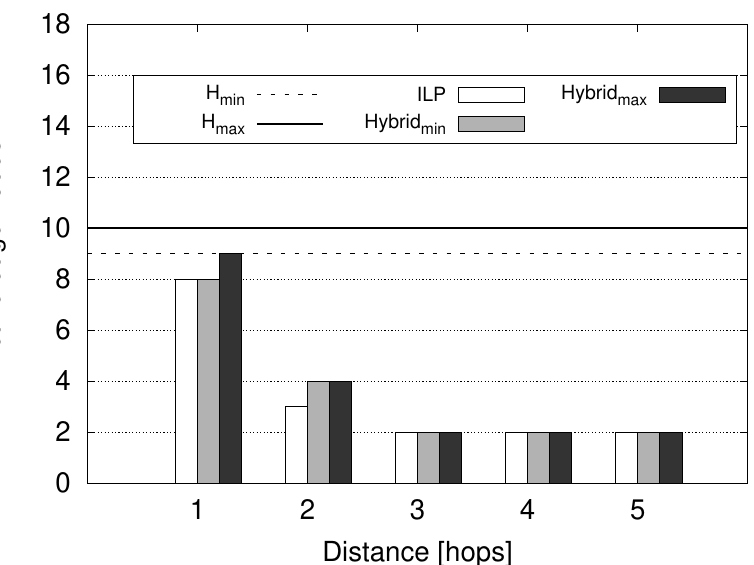
Figure 3. Total number of active edge nodes as a function of the allowed distance between RRUs and edge nodes for network N 14 : Maximum and minimum costs of the hybrid results are reported after both